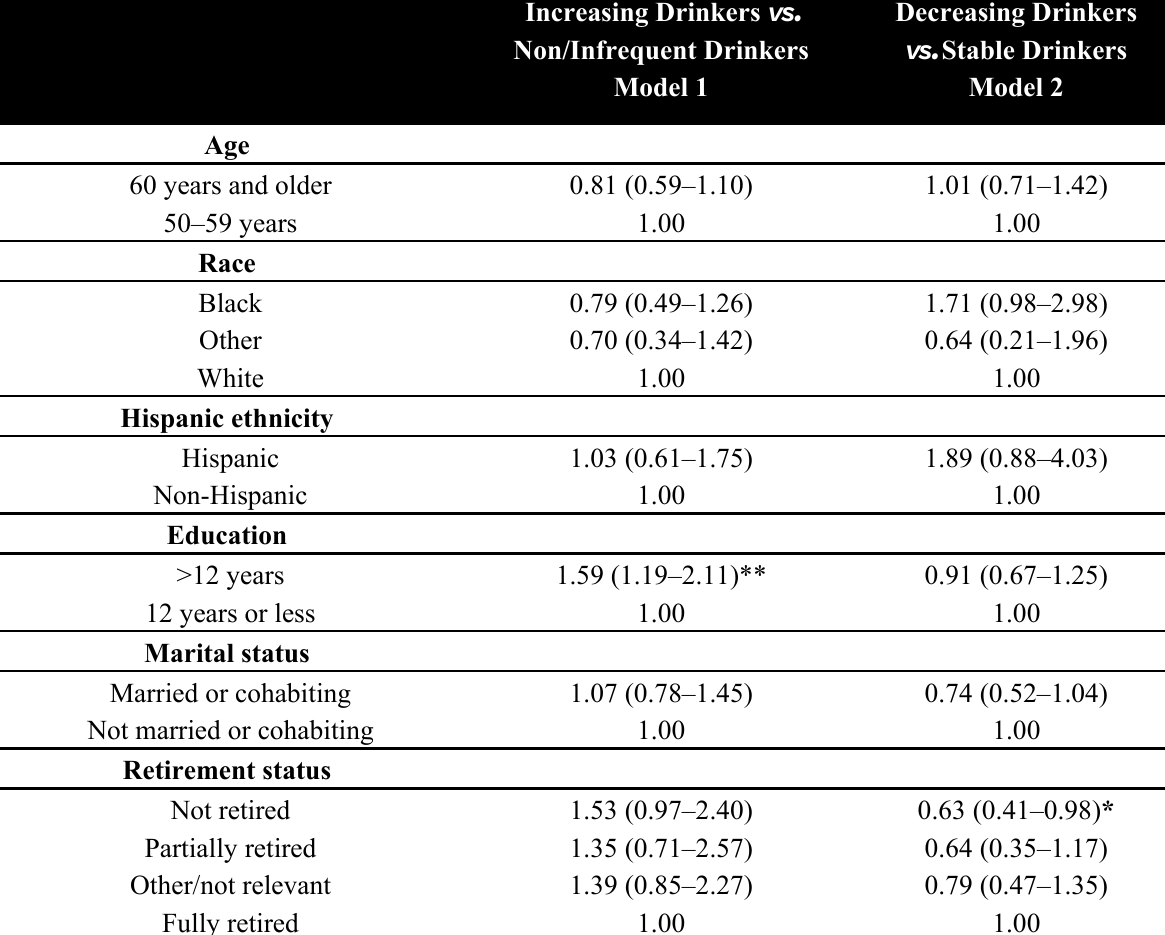
Table 2. Adjusted odds ratios and 95% confidence intervals for 1998 characteristics and changing versus consistent drinking trajectories among HRS women ages 50–65.